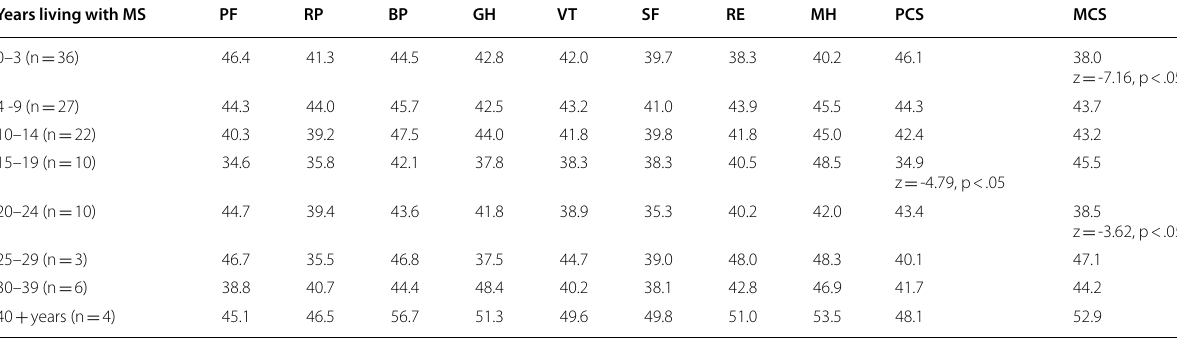
PF physical function, RP role physical, BP bodily pain, GH general health, VT vitality, SF social function, RE role emotional, MH mental health, PCS physical component summary, MCS mental health component summary